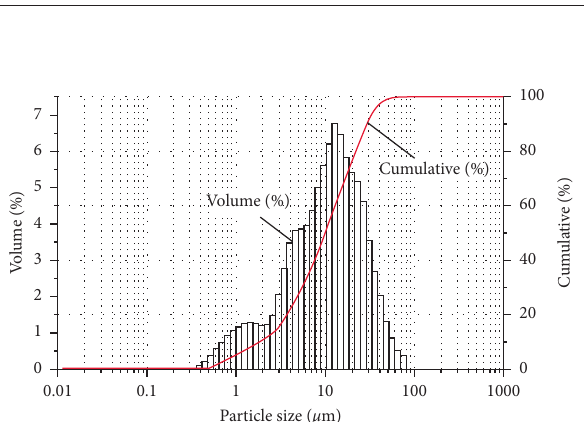
Table 2: The basic physical and mechanical properties of the cement used in the tests. Initial setting Cement Specific surface area (m 2 /kg) time (h)